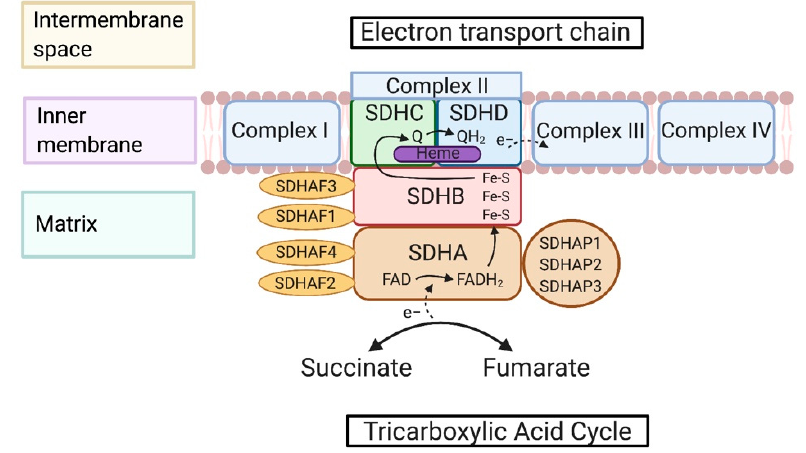
Figure 1. Structure, maturation, and assembly of succinate dehydrogenase (SDH) complex. The SDH complex, or mitochondrial complex II, sits within the inner mitochondrial membrane and is included in both the tricarboxylic acid cycle (TCA) and the electron transport chain (ETC). Succinate is an enzyme that is a part of the TCA cycle and is oxidized to fumarate through SDH; this is also present in the reverse reaction. From the oxidization, two electrons are transferred to subunit A to protonate FAD to FADH 2 and release two electrons to the Fe-S clusters housed within subunit B. Assembly